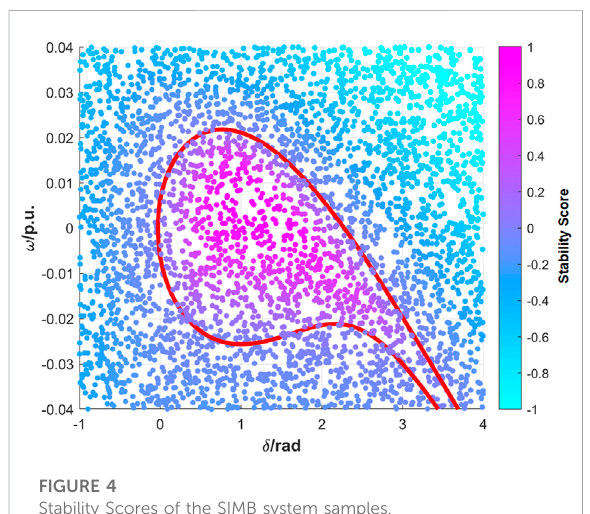
FIGURE 4 Stability Scores of the SIMB system